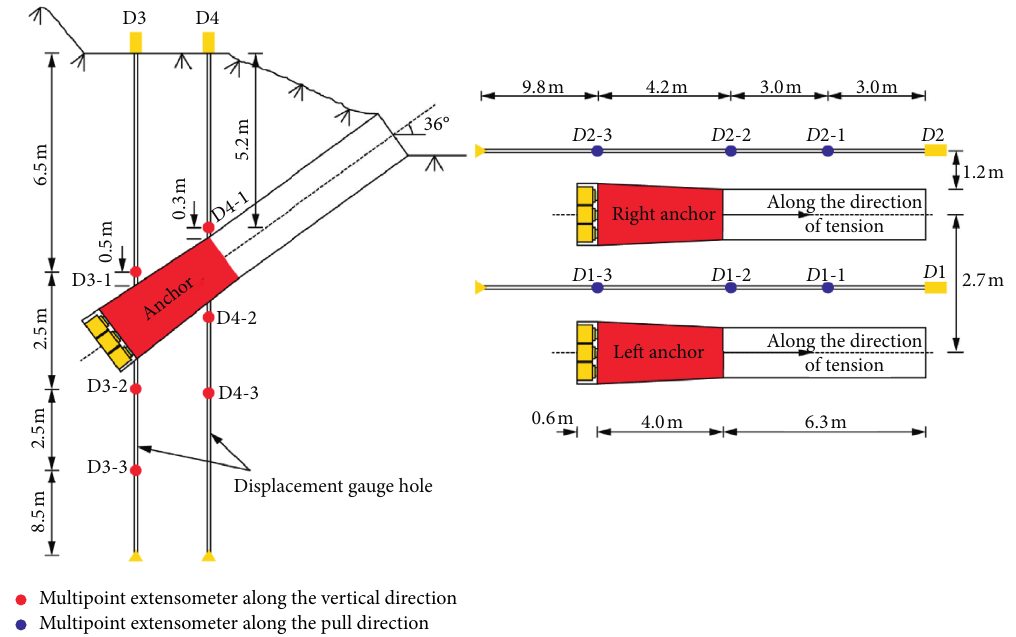
Figure 11: Multipoint displacement transducers along the (a) vertical direction and (b) tensile direction.